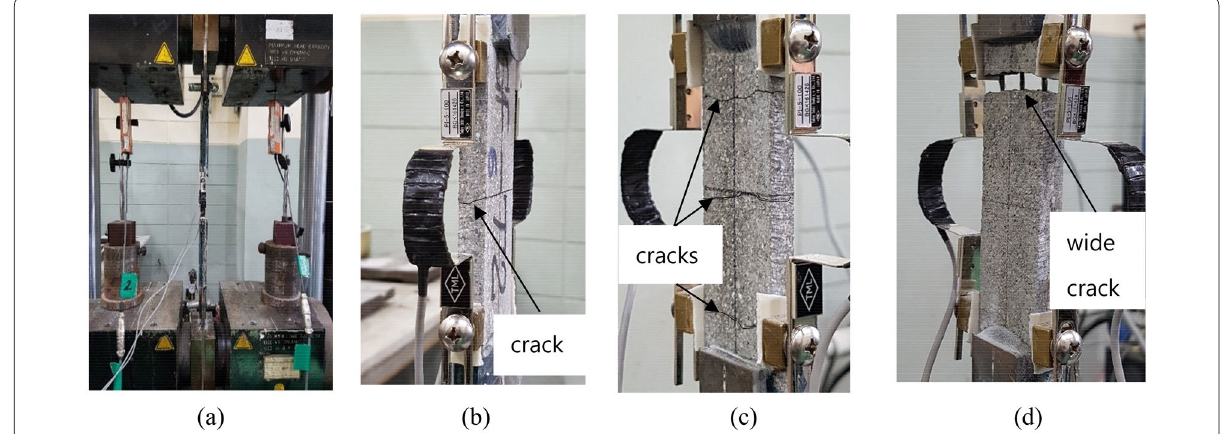
Fig. 7 Tensile test on FRCM composites: a test setup, b at cracking, c multiple cracks, d a dominant